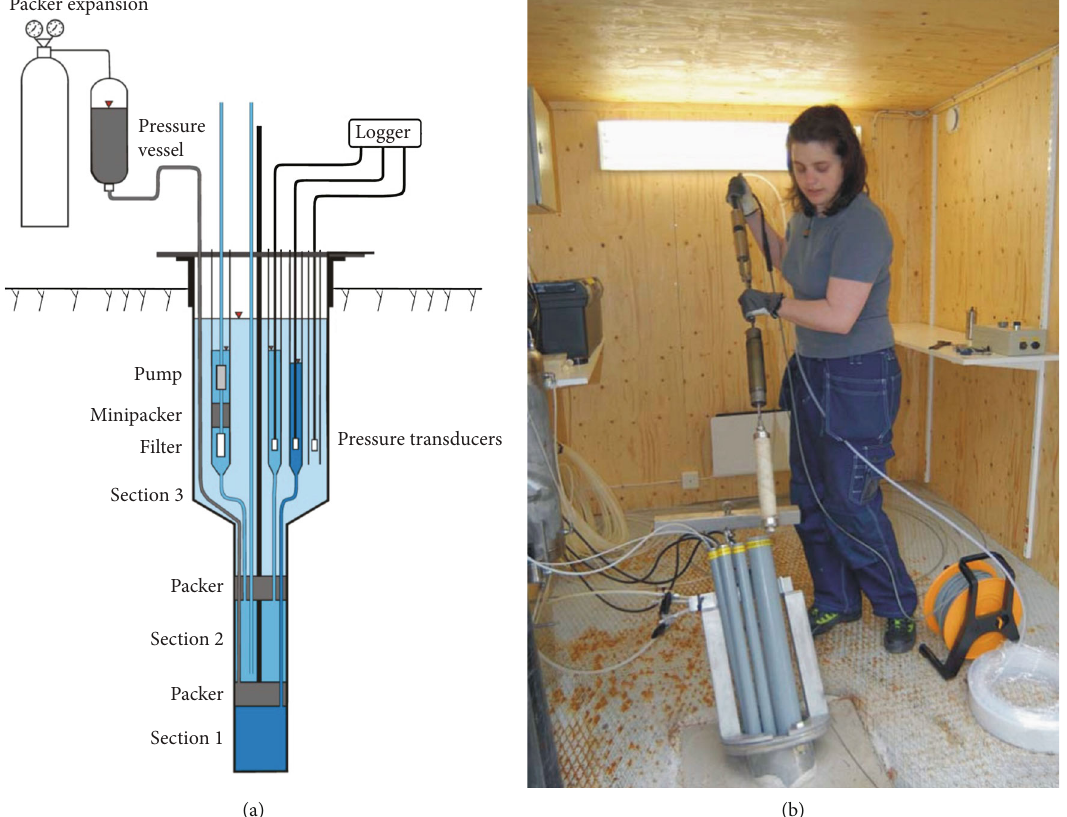
Figure 4: (a) Installed equipment for pressure, groundwater sampling, and groundwater fl ow monitoring in a telescopic borehole. A maximum of 10 pressure sections can be installed in a telescopic borehole, of which generally two are equipped for water sampling and circulation of tracers during fl ow measurements. These circulation sections are connected to three tubes. Two of them connect the section to the two standpipes for pressure measurements and groundwater sampling (the wider pipe), respectively, in the uppermost part of the borehole. The third tube leads all the way to the ground surface for the circulation experiments. (b) Lowering of a pump connected to a minipacker (for isolating the standpipe from the atmosphere) and a 50 μ m fi lter (polyamide) into a large diameter standpipe. To collect samples, pumping is conducted in the closed standpipe (cf. (a)); when the pressure decreases, groundwater from the connected borehole section is sucked into the standpipe and pumped to the ground surface. Modi fi ed from